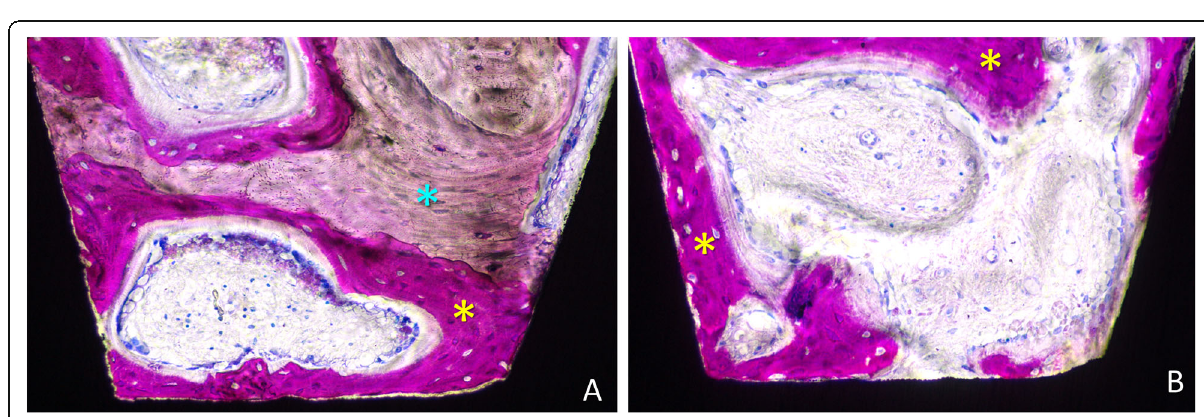
Fig. 6 Photomicrographs of ground sections of devices installed with insertion torque ( a ) < 10 Ncm and ( b ) ~ 30 Ncm. Note newly formed bone (yellow stars) and pre-existing old bone (light blue stars) and marrow spaces. Image originally taken at × 200 magnification. Acid fuchsine and toluidine blue stain